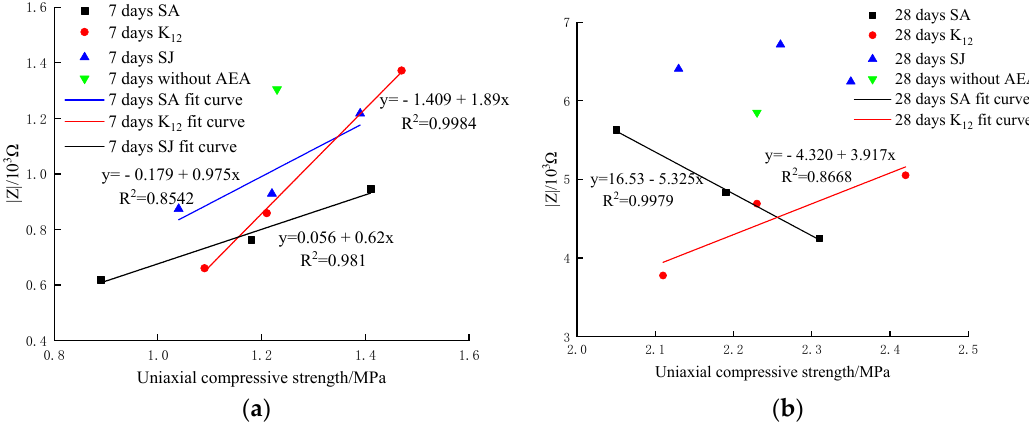
Figure 14. Relationship between the uniaxial compressive strength (UCS) and the AC impedance at 10 5 Hz. ( a ) represents the filling body with di ff erent AEAs at the 7 days curing age; ( b ) represents the filling body with di ff erent AEAs at the 28 days curing